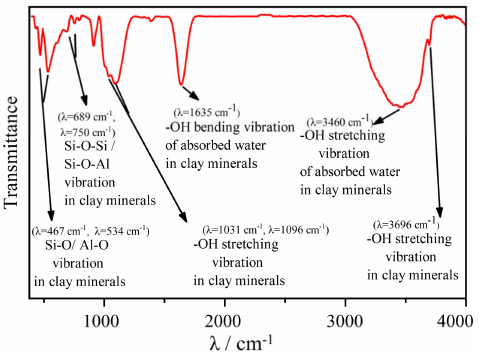
Figure 2. Infrared spectroscopy of the IREO colloids.